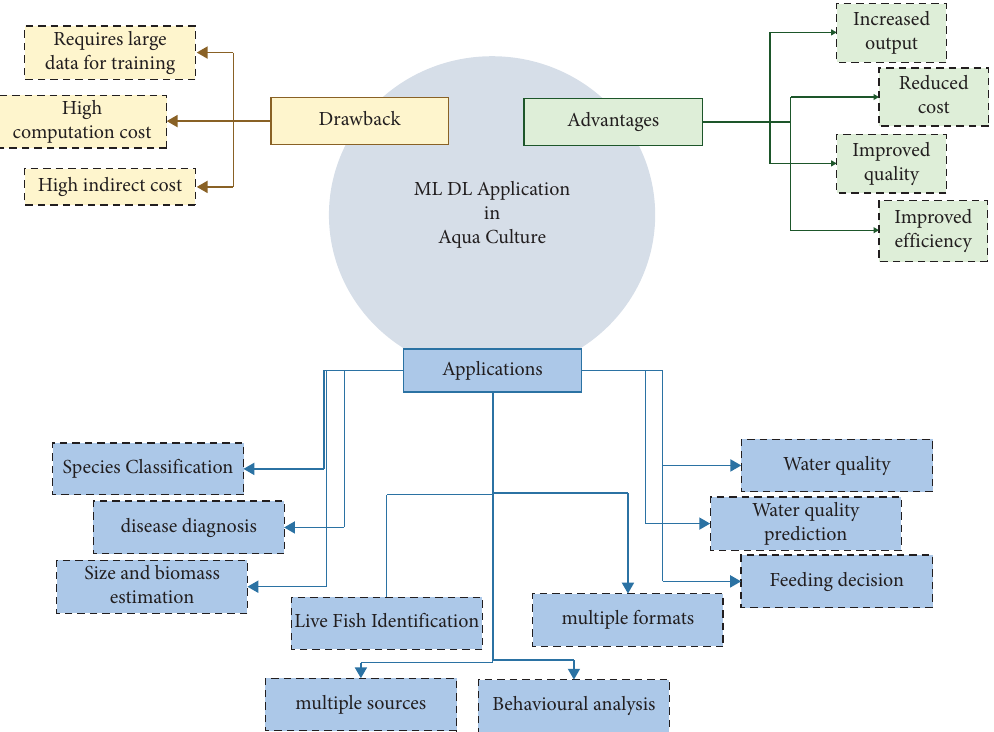
Figure 1: Application, advantage, and drawback of ML and DL in aquaculture